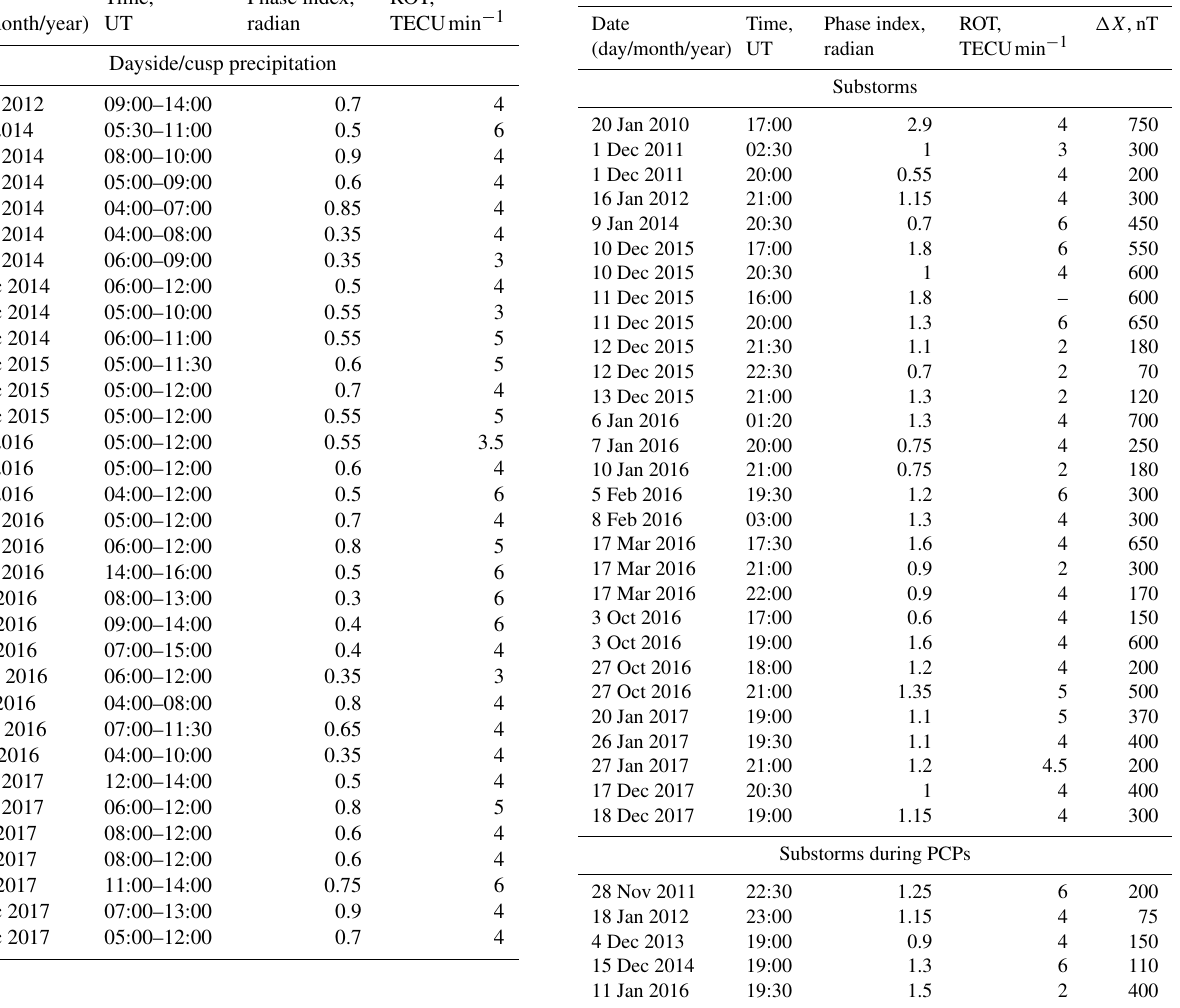
Table 1. The values of the phase scintillation index and ROT, deter- mined from the GPS receiver at NYA station, during dayside/cusp precipitation events.